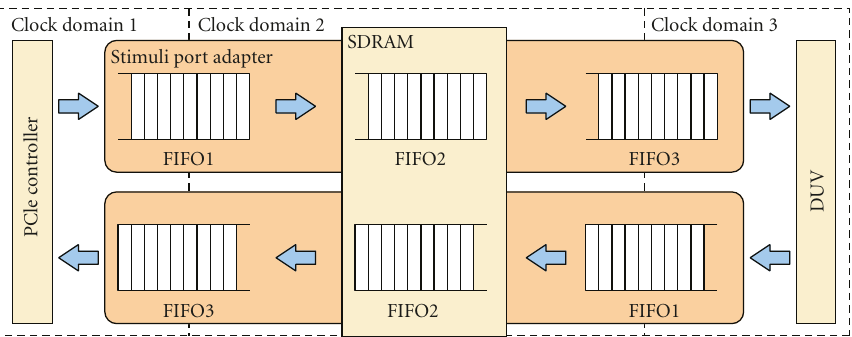
Figure 6: Structure of port adapters.